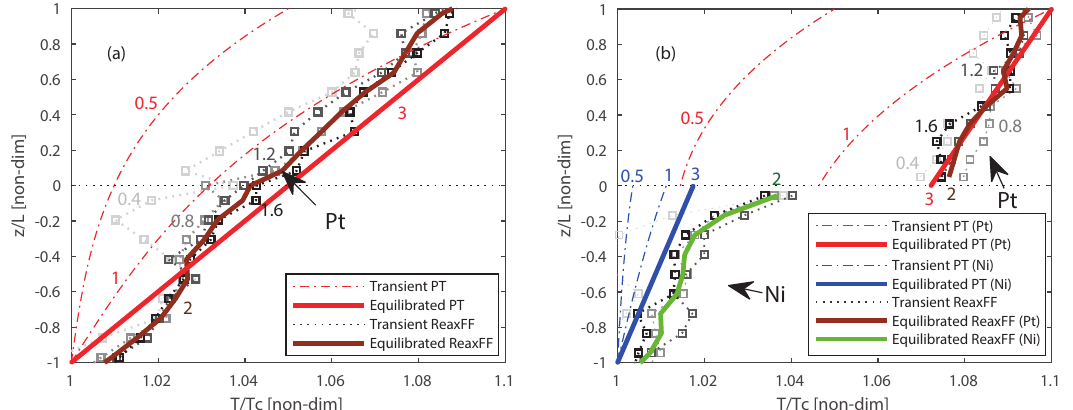
Figure 7. Comparison of temperature profile computed from PT based model and ReaxFF MD simulation for: ( a ) Pt/Pt interface. ( b ) Pt/Ni interfaces. The solid lines represent the equilibrated, and the dashed/dotted lines the transient temperature profiles. The dashed-dotted lines are intermediate transient temperature profiles for PT, and the dotted lines with square markers represent intermediates from ReaxFF MD simulations. The corresponding numbers at the lines represent t non-dim